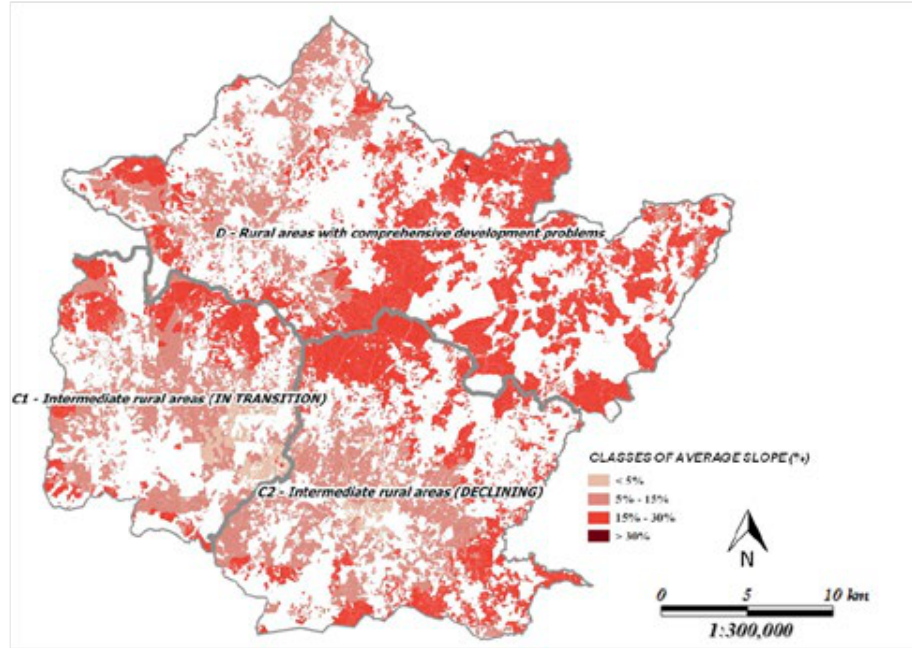
Figure 4. Farmland areas in Mugello according to classes of average slope.